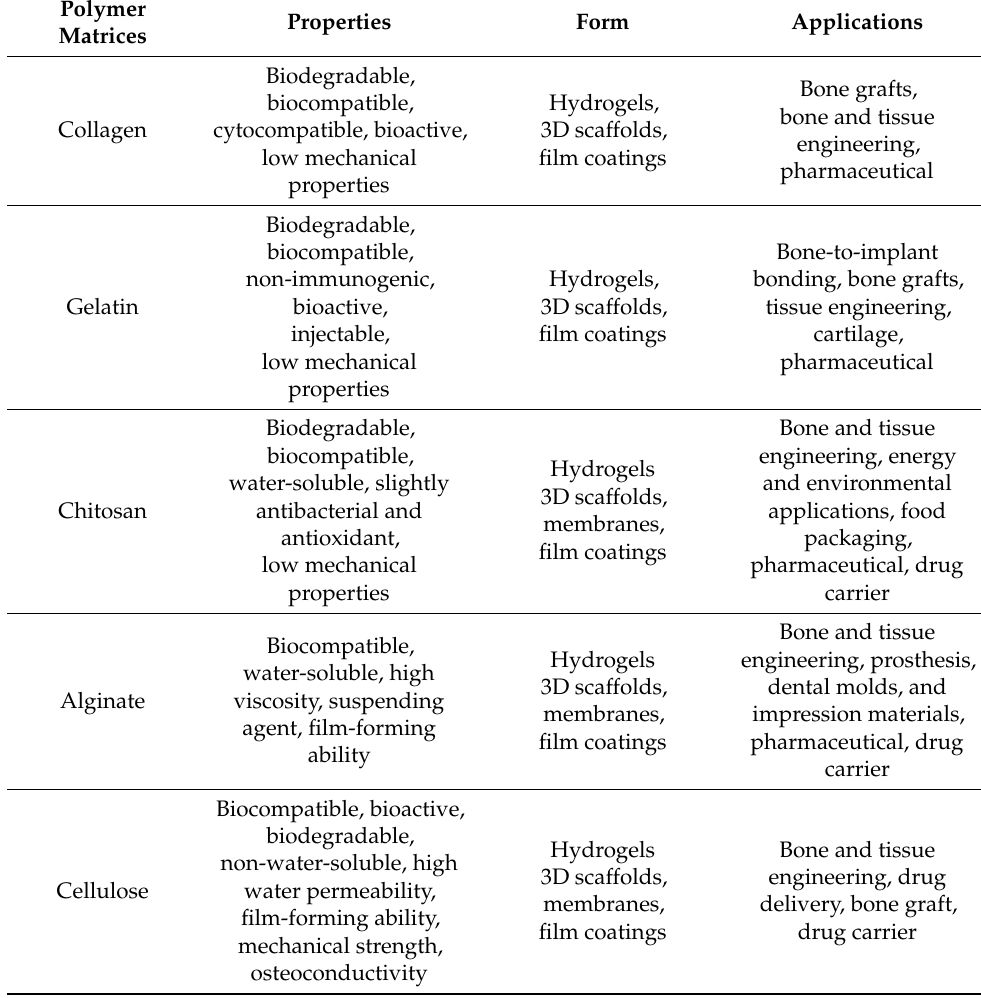
Table 1. CaP containing natural polymer composites in bone tissue